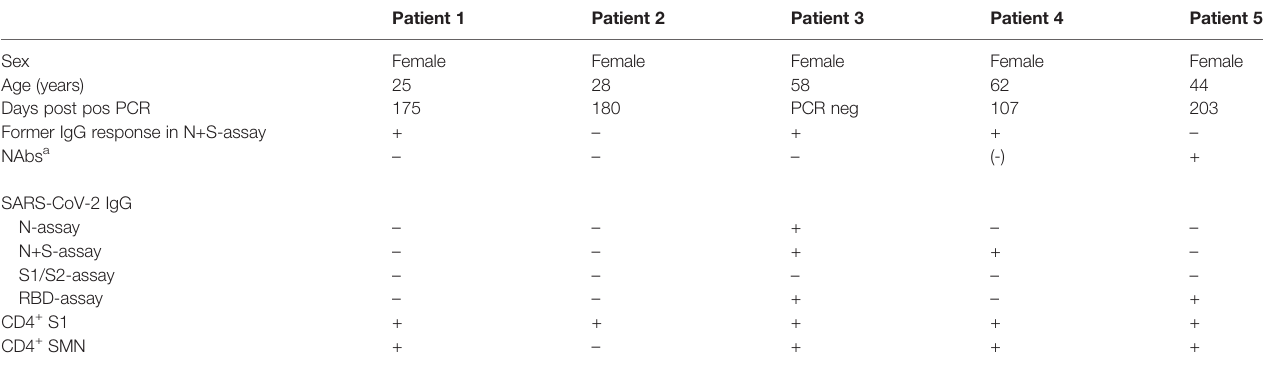
TABLE 3 | Health care workers de fi ned with veri fi ed* COVID-19 yet without detectable neutralizing antibodies (NAbs) and/or IgG in the N and N+S-assay at time-point 4 (21 th of September – 8 th of October